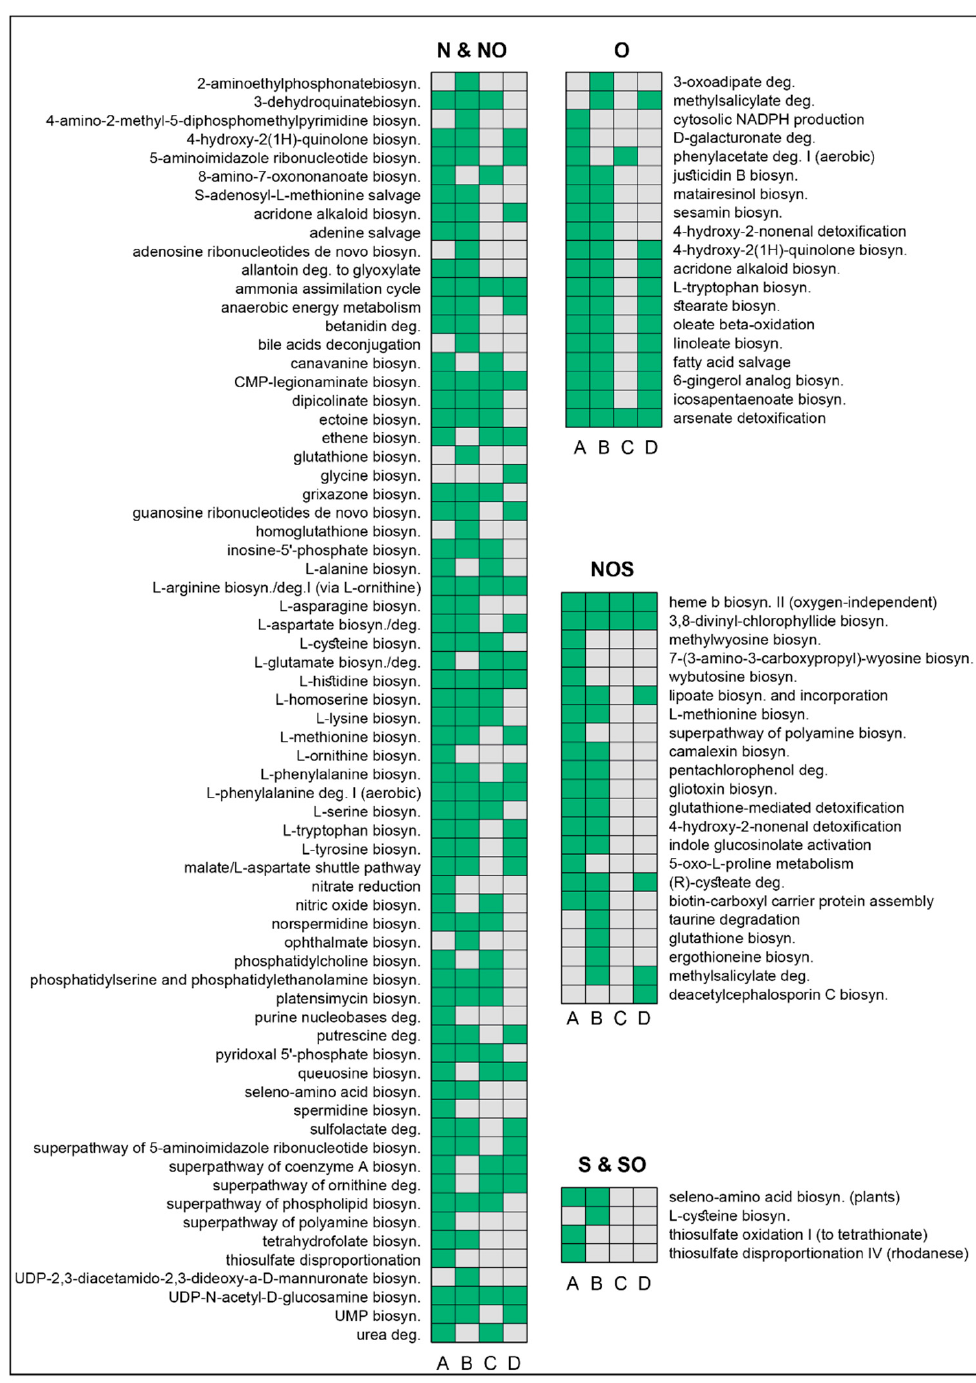
Figure 5. Metabolic pathways that are employed by the strains to degrade NAFCs. The compounds identified by matching the EC numbers of gene products in the RNA-seq libraries with enzymatic reactions in the MetaCyc database were categorized based on their heteroatomic composition into (1) N and NO, (2) O, (3) NOS and (4) S and SO classes. We subsequently determined the biodegradation pathways of these compounds by matching the chemical IDs (CID) of the substrates to EC numbers of putative enzymes and later interrogating all combinations of CID-EC combinations in the entire MetaCyc database. We identified pathways for (A) P. protegens in the 1:1 co-culture, (B) P. protegens cultured individually, (C) P. putida in the 1:1 co-culture and (D) P. putida cultured individually. Green boxes denote presence and grey boxes denote absence of a particular pathway. The codes used to generate this plot are published in the Jupyter notebooks that has been included in the ESI